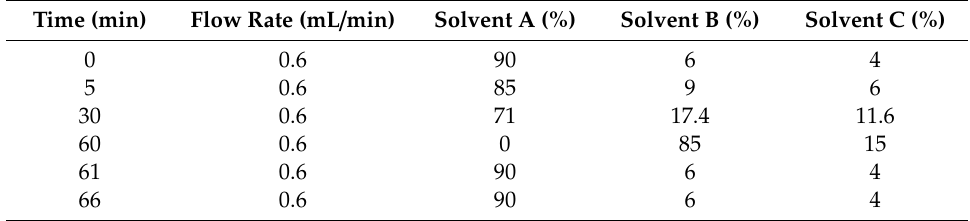
Table 1. Solvent system of the phenolic acids and flavonoids using high performance liquid chromatography (HPLC)